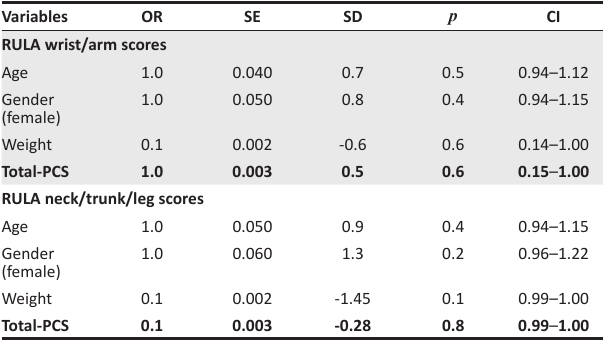
TABLE 5: Generalised estimated equations model for rapid upper limb assessment.